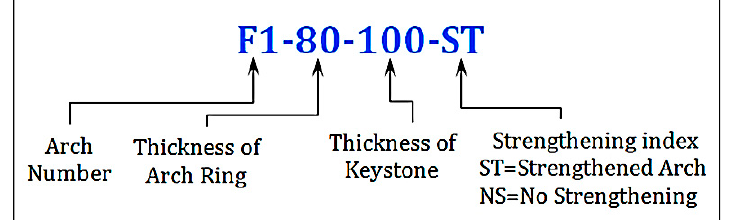
Figure 2. Designation system for self-form segmental concrete masonry arches.